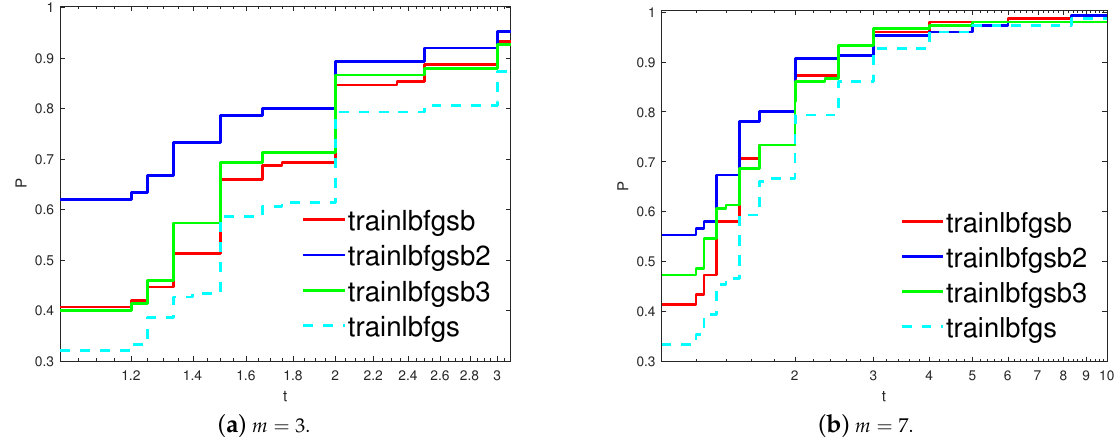
Figure 9. Log 10 scaled performance profiles based on accuracy for the Coimbra classification problem.